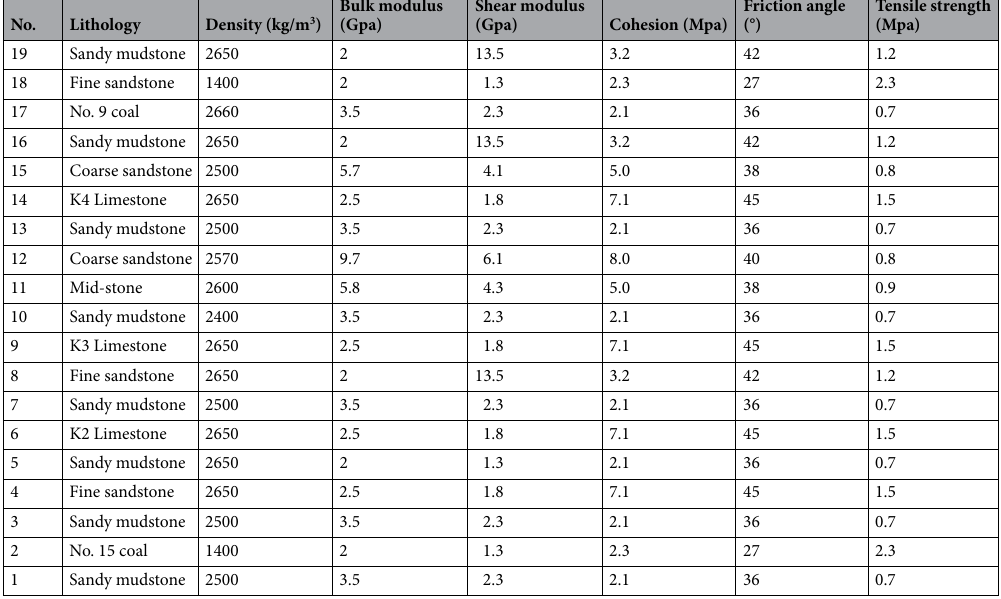
Table 1. Overburden